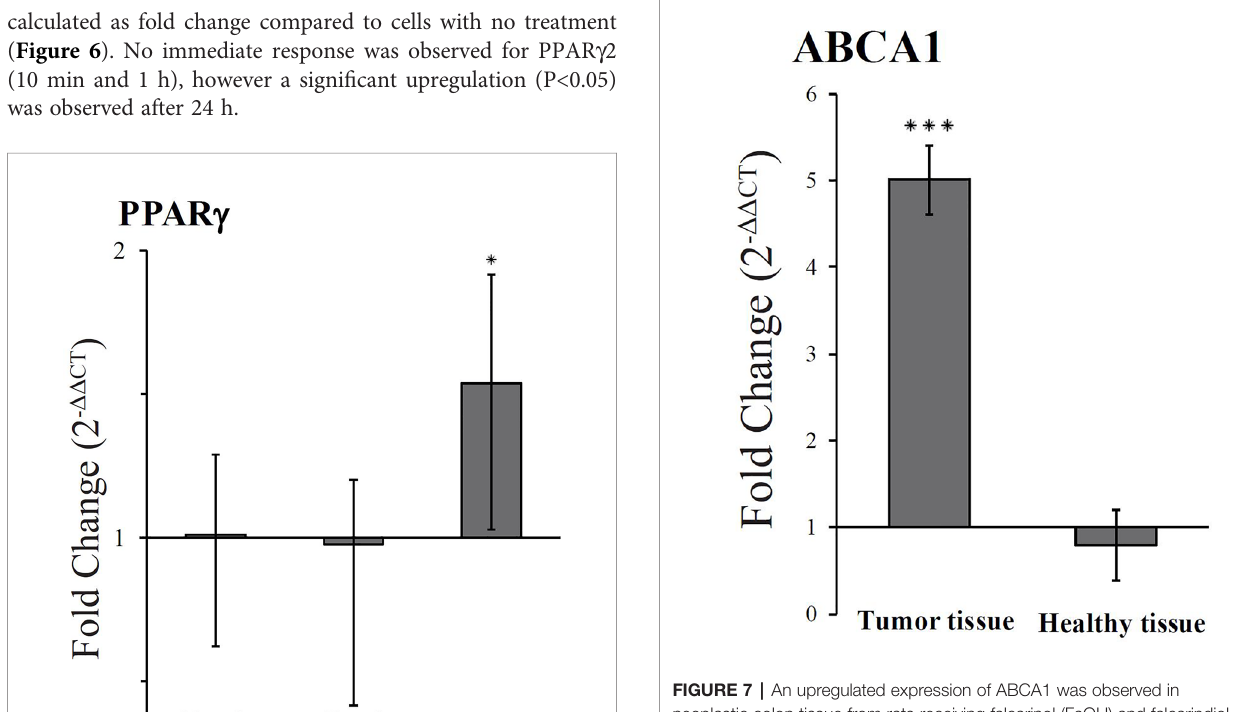
FIGURE 7 | An upregulated expression of ABCA1 was observed in neoplastic colon tissue from rats receiving falcarinol (FaOH) and falcarindiol (FaDOH) in the diet compared to the neoplastic colon tissue from rats not receiving FaOH and FaDOH in the diet (control). This upregulation is neither seen in healthy colon tissue from rats receiving FaOH and FaDOH in the diet or receiving only a control rat diet. Dark gray bars represent neoplastic tissue and light grey bars represent healthy tissue. All values represent the mean ± SD. *** P <